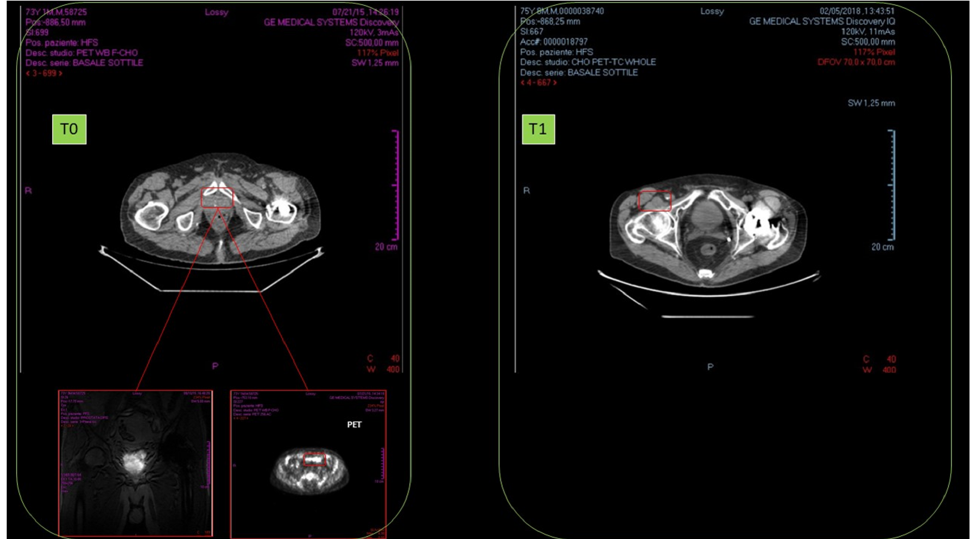
Figure 16. Disappearance of radioresistant prostate carcinoma (T0) after 1 year of HOO treatment (T1), as detected by nuclear magnetic resonance in a 76-year-old male patient.